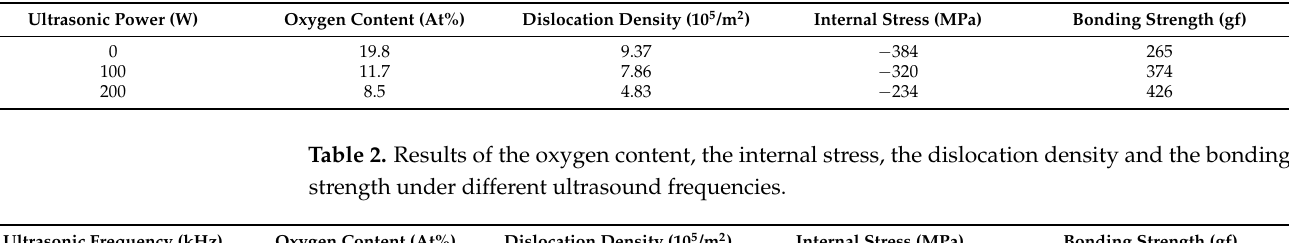
Table 1. Results of the oxygen content, the internal stress, the dislocation density and the bonding strength under different ultrasound powers.